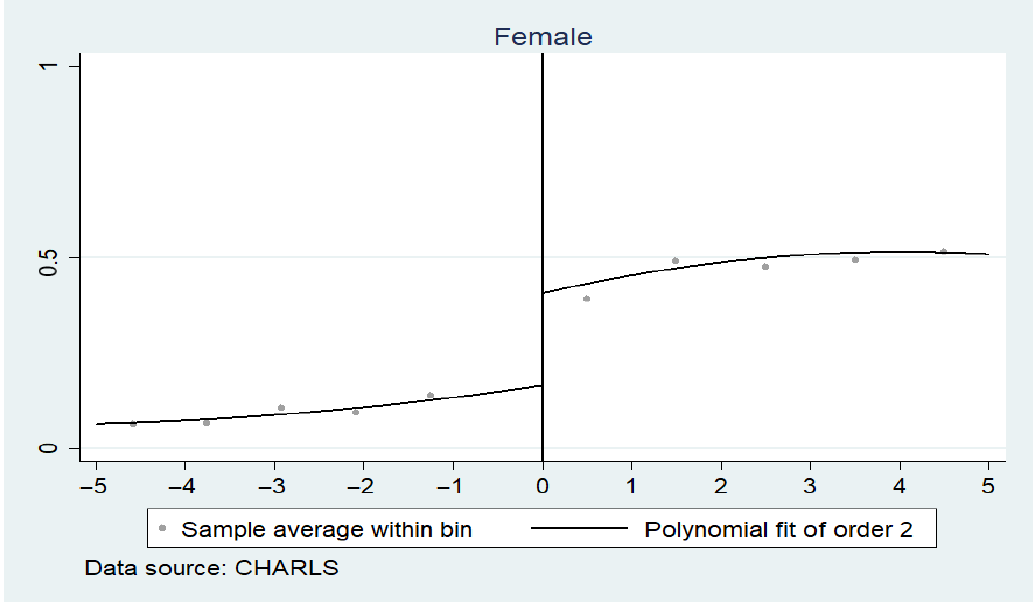
Figure A2. Discontinuity diagram of the average retirement rate of women by